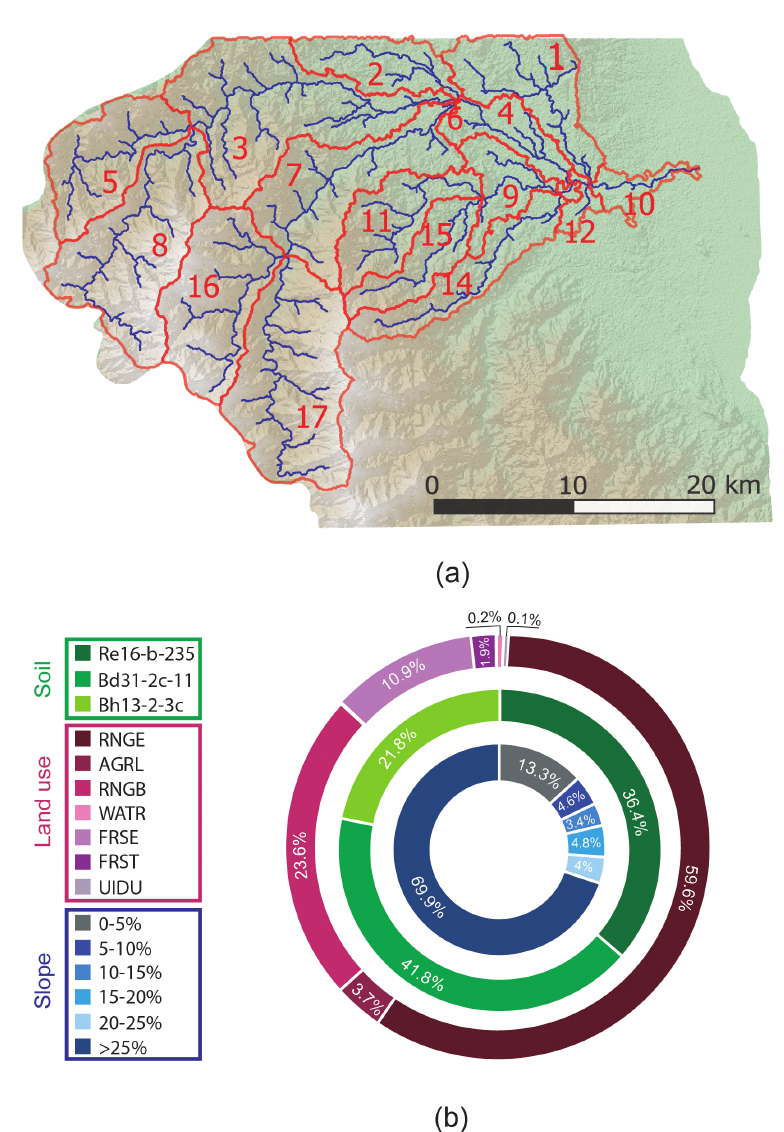
Figure 6. Delineation of the watershed and the river network ( a ), and percentage of the land use, soil, and slope categories across the basin ( b